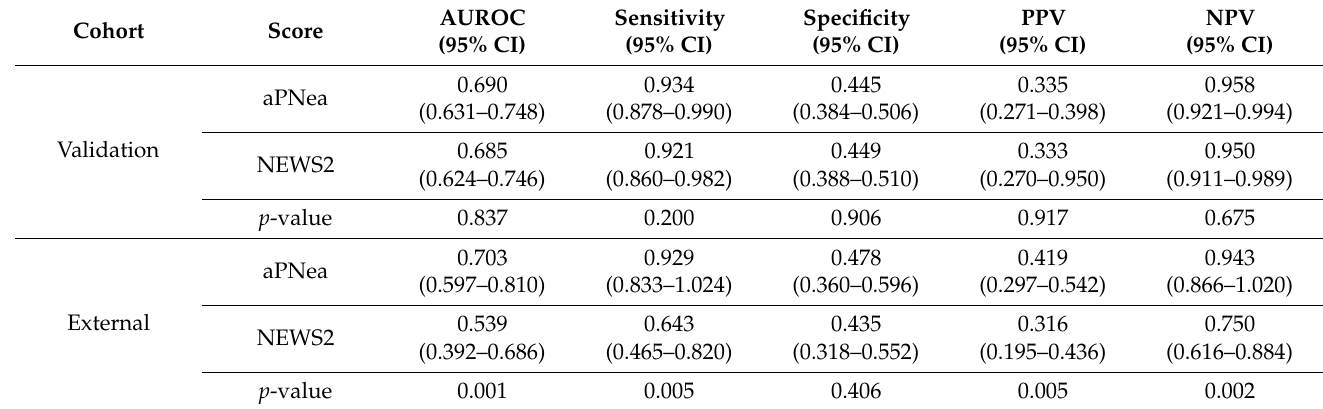
Table 5. Score metrics comparison based on an aPNea cut-off of 5 and a NEWS2 cut-off of 1.